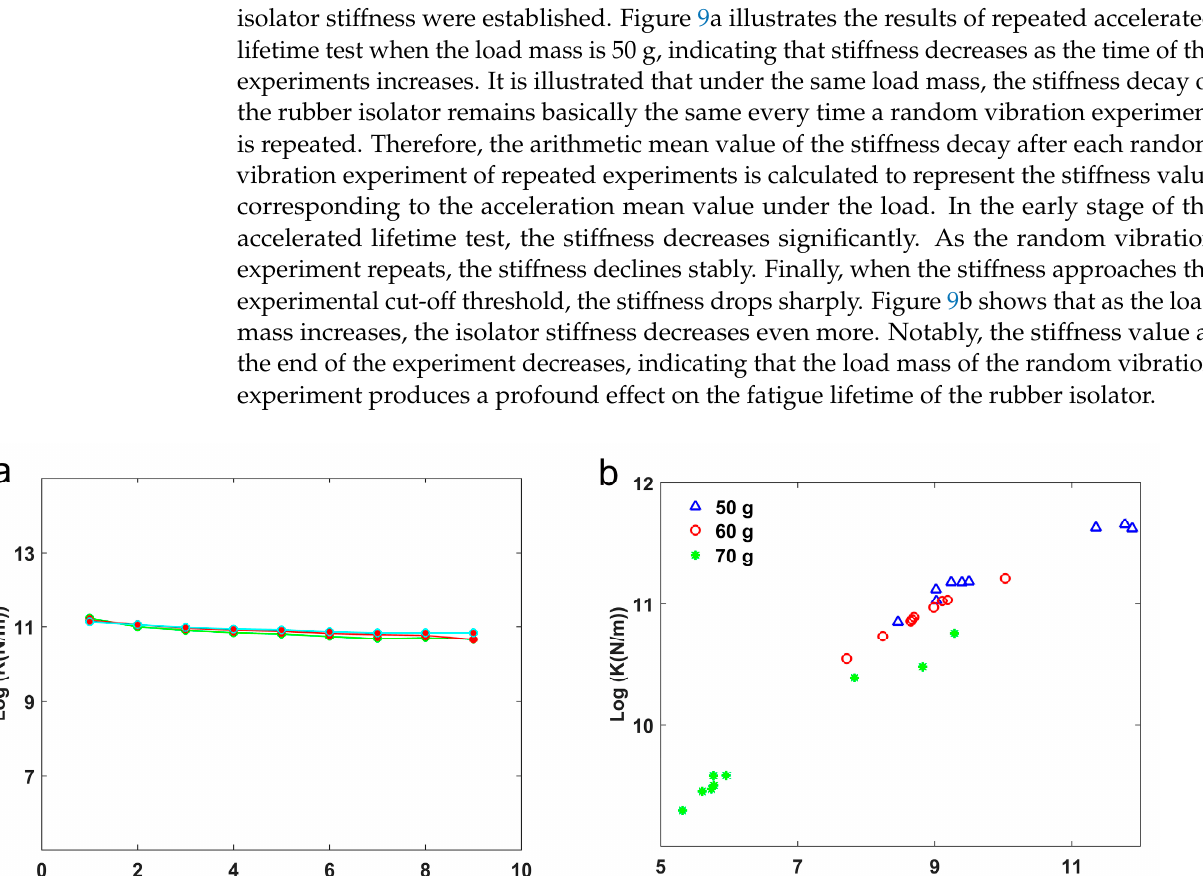
Table 1. Coefficient fitting